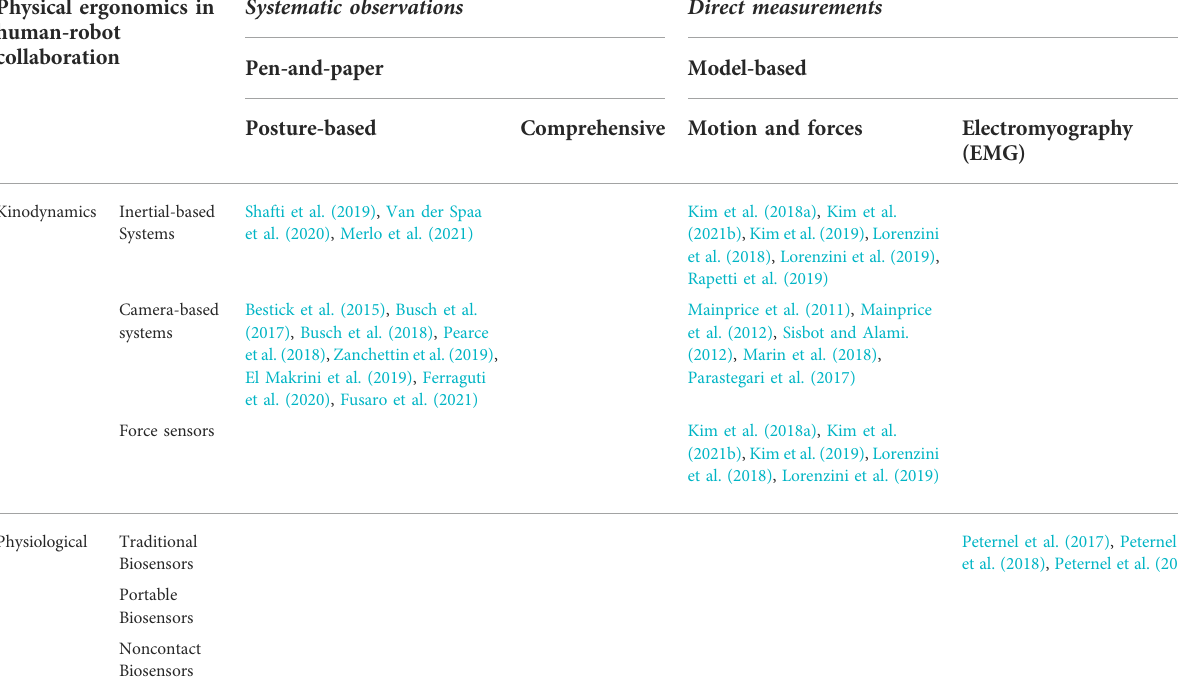
TABLE 1 Physical ergonomics in industrial HRC: distribution of works among main monitoring systems and ergonomic assessment techniques. Physical ergonomics in